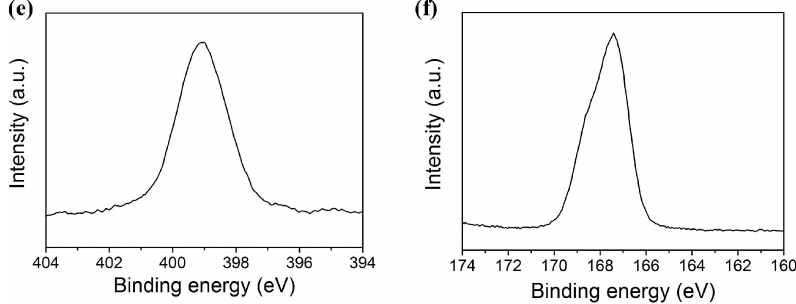
Figure 6. The X-ray photoelectron spectroscopic (XPS) spectra of GO and HBS-rGO: all elements survey scan of GO ( a ), HBS-rGO ( b ), C 1s survey scan of GO ( c ), HBS-rGO ( d ), ( e ) N 1s, and ( f ) S 2p for HBS-rGO.